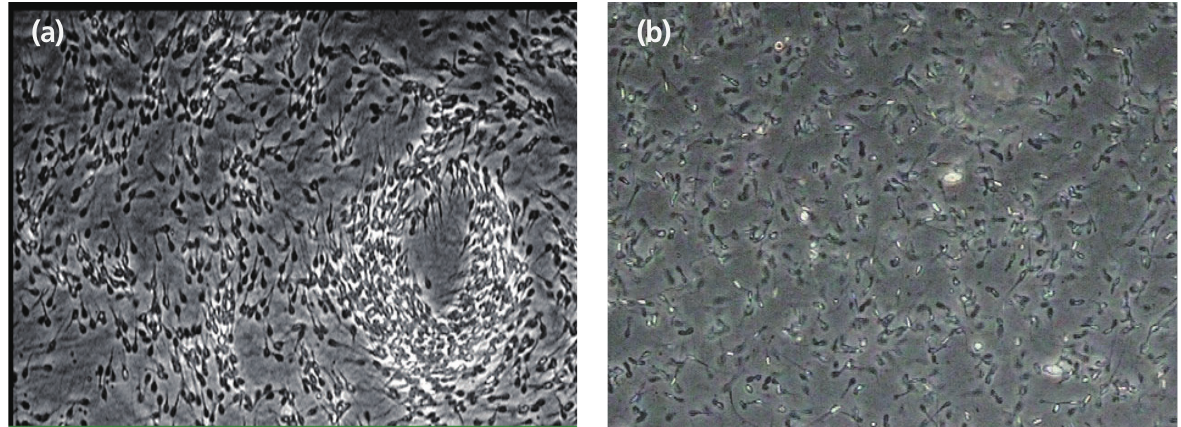
Figure 4. High- and low-motility sperm morphology under optical microscope. The sperm sample with high motility (a) and the sperm sample with low motility (b). Sperm Motility means the ratio of sperm moving forward in a straight line. (a) 400x; (b) 400x.